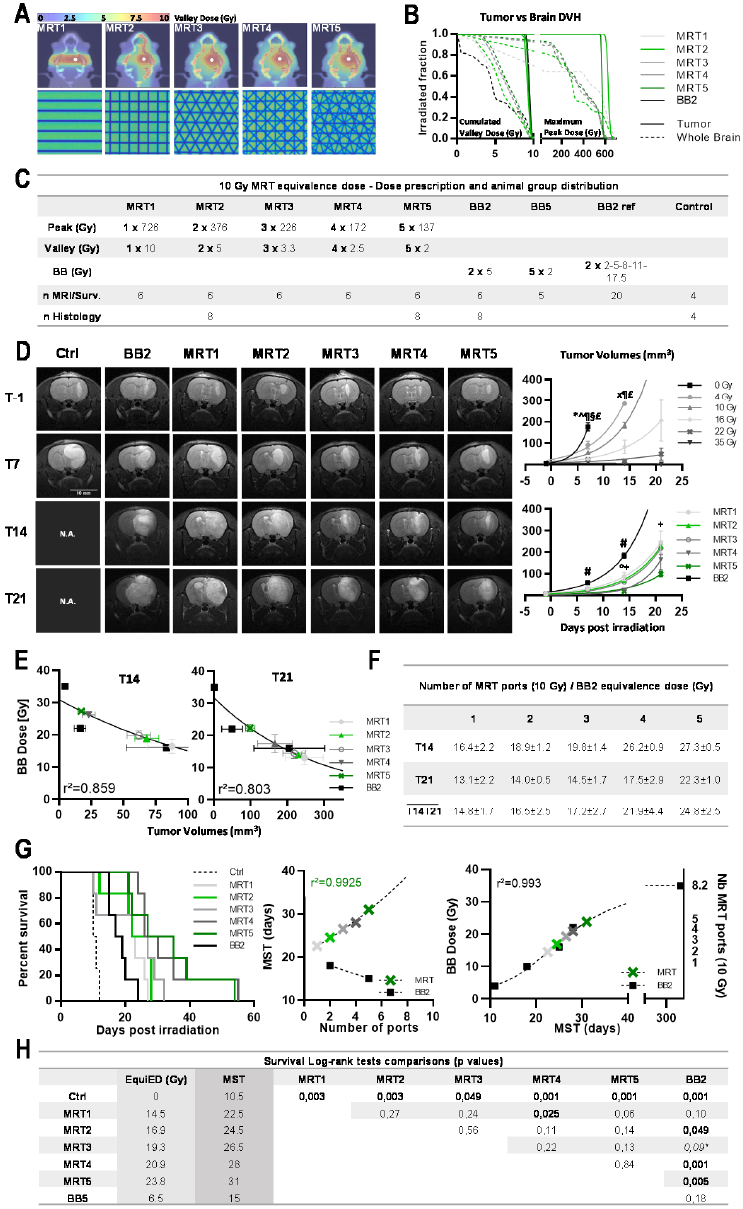
Figure 3. Each supplementary MRT port improved tumor control and contributed to the exponential extension of MST. ( A ) Irradiation geometries and valley dose maps computed on IsoGray for 9L glioma-bearing rats. BB2 was delivered through 2 orthogonal 8 × 8 mm 2 beams (2 × 5 Gy) while MRT (microbeam width 50 µ m, 400 µ m spacing) was delivered via 1 (valley dose at target 10 Gy, peak dose 726 Gy) to 5 isocentric ports, spaced at 36 ◦ and intersecting in the right caudate nucleus (valley dose at target 5 × 2 Gy, peak dose 5 × 137 Gy). ( B ) Whole brain and tumor